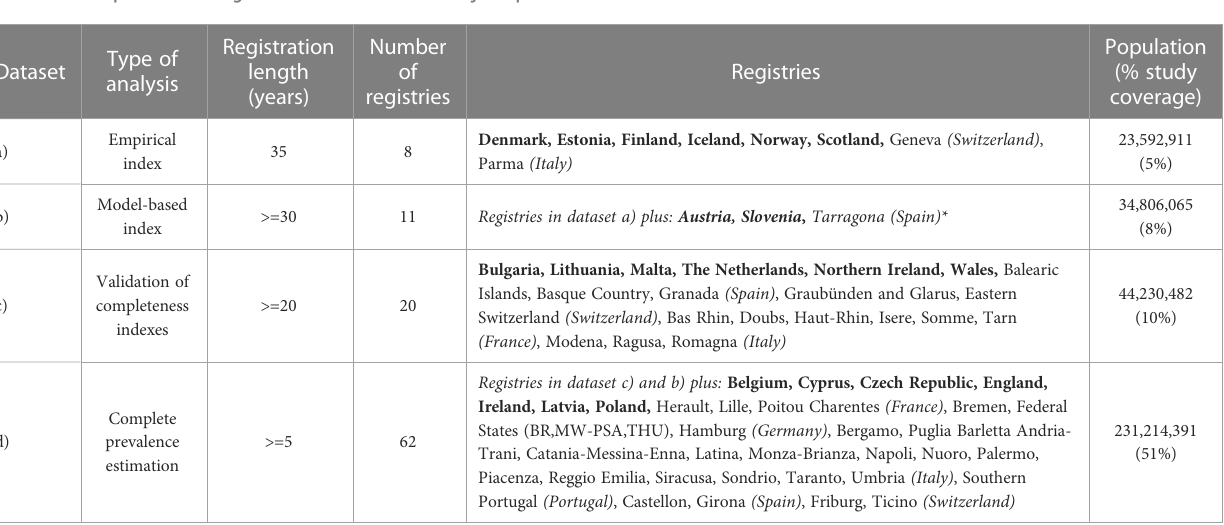
TABLE 1 Description of the registries included in each analysis-speci fi c